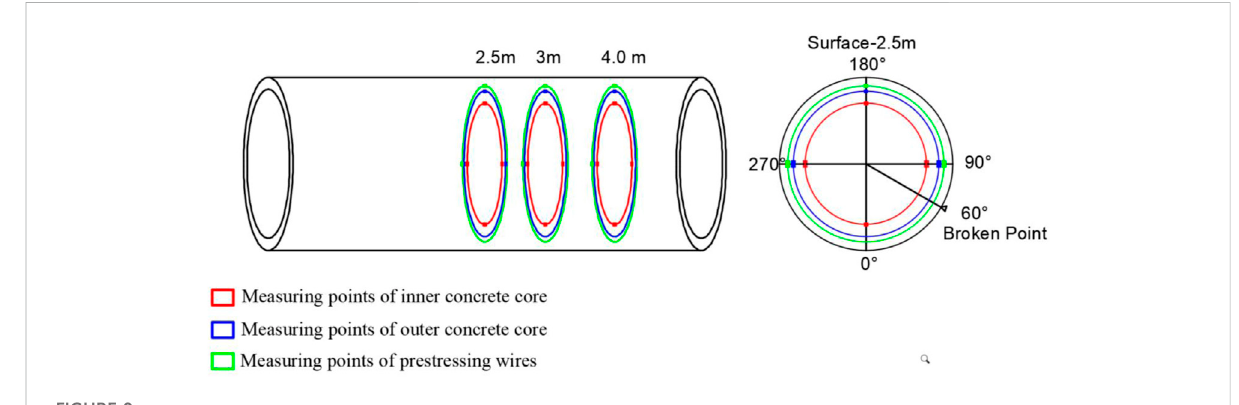
FIGURE 9 Layout of measuring sections (Dimension: mm).